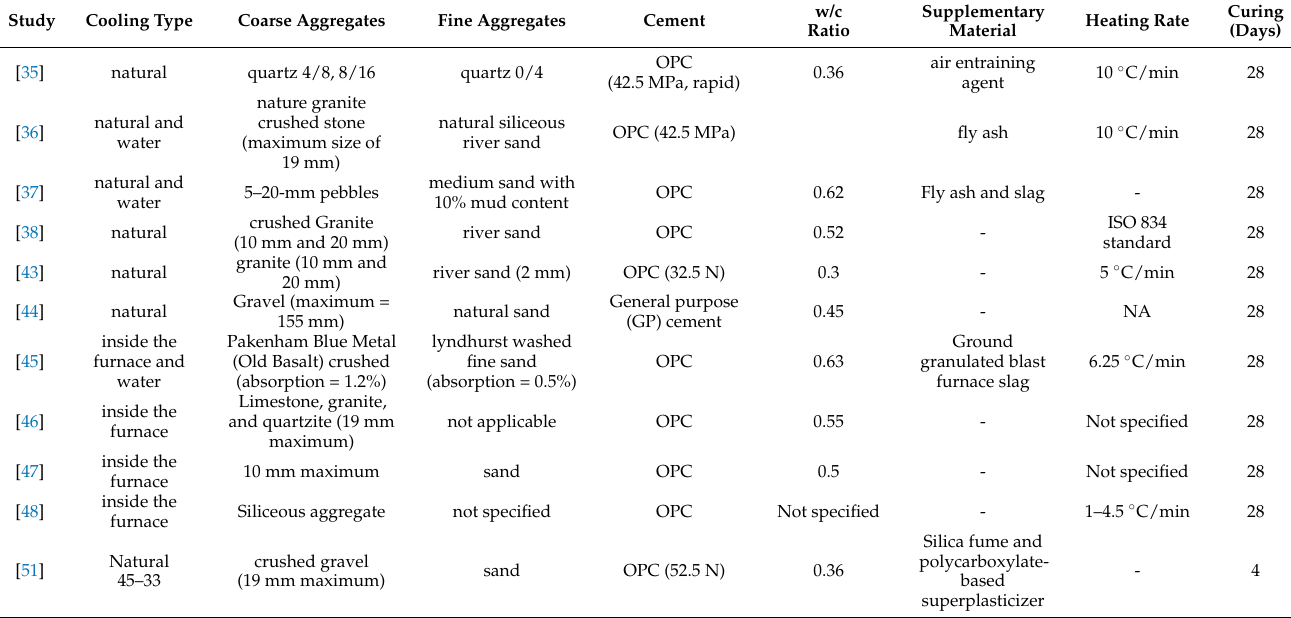
Table 1. Important parameters of different studies on NSC